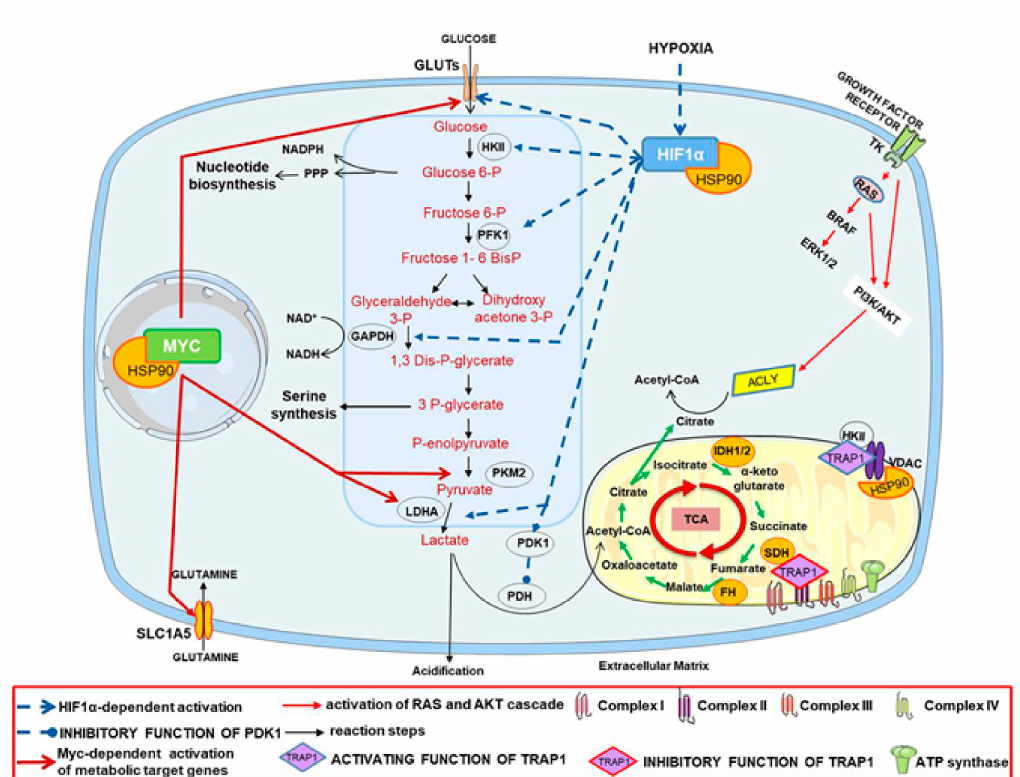
Figure 1. Heat shock protein 90 (HSP90) regulates metabolic pathways. HSP90s interact and